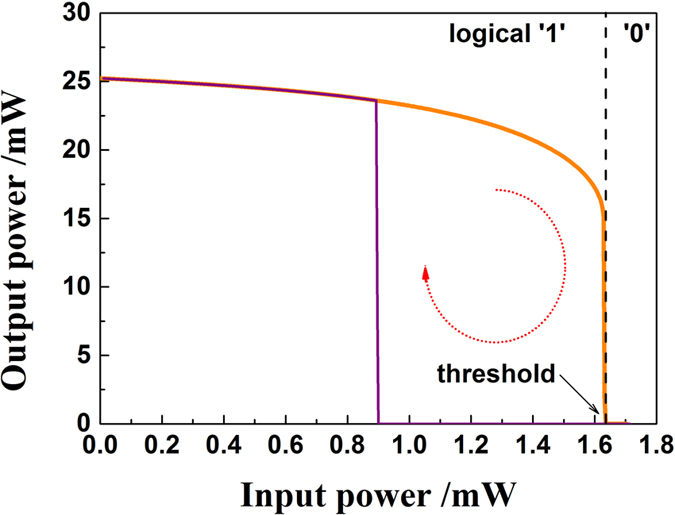
Transfer function of the all-optical analog comparator under the operational point (L = 600 μm, κ = 20 cm−1, r = 10−4 and I = 4Ith).